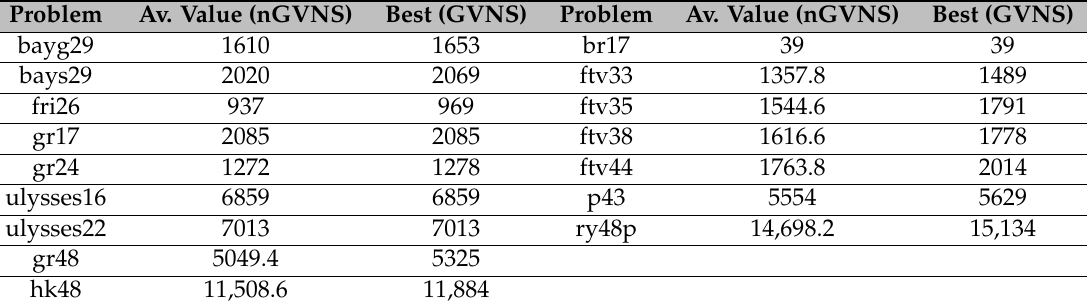
Table 4. Data based on the novel GVNS and the conventional GVNS [35].